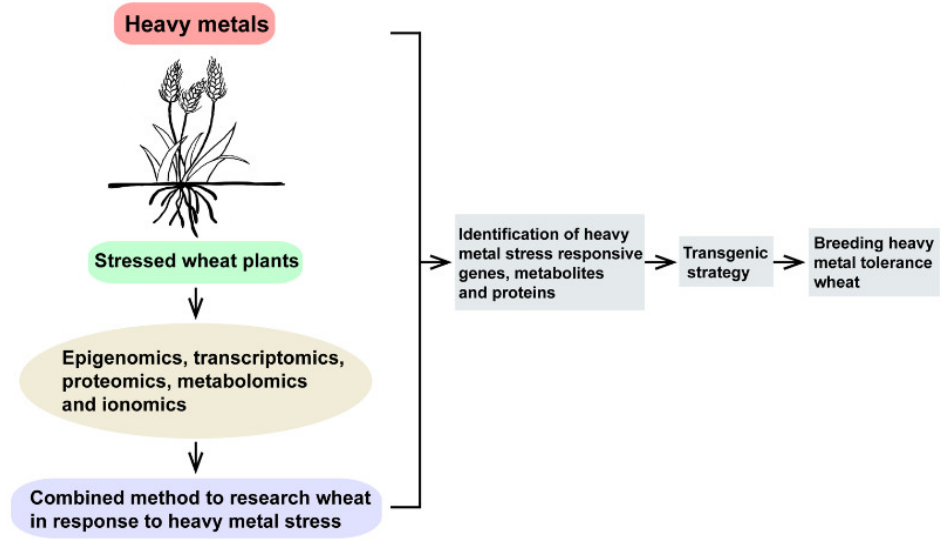
Figure 4. Combined method to investigate wheat plants in response to heavy metal stress. Epige- nomics, transcriptomics, proteomics, metabolomics and ionomics are useful methods that can help us to clarify and analyze active regulatory networks regulating heavy metal stress responses and tolerance in wheat plants.